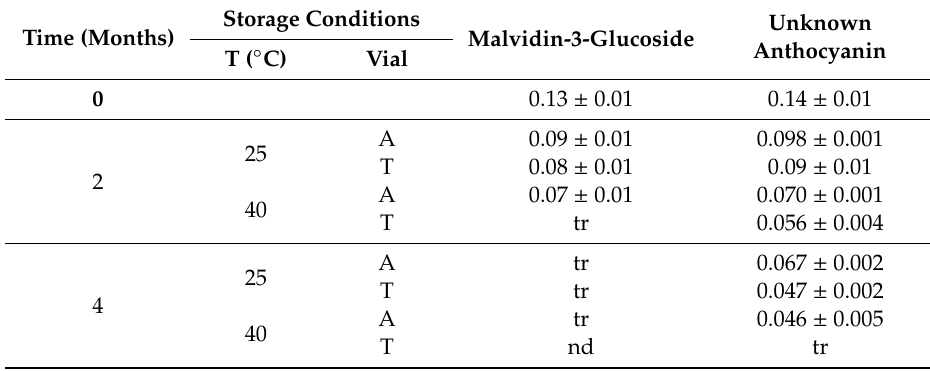
Table 2. Concentration of anthocyanins ( µ g / mg extract) in grape stem extracts during the storage at di ff erent conditions of temperature and light (T: transparent vial, A: amber